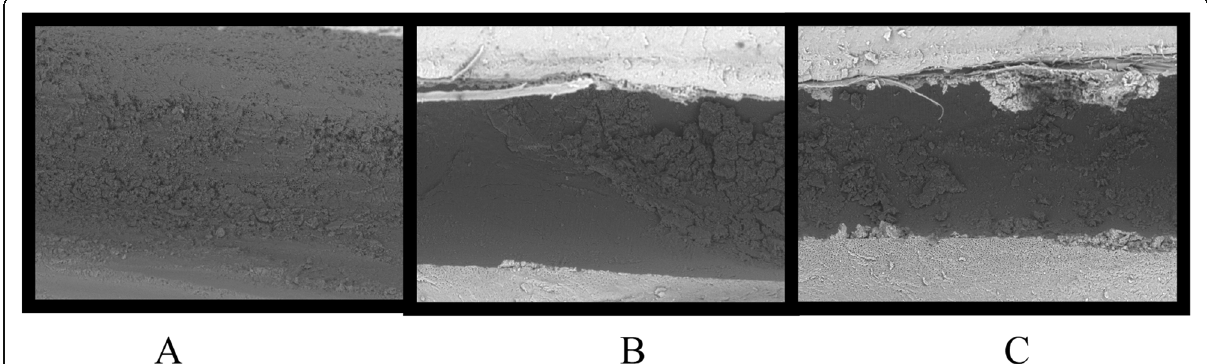
Fig. 9 SEM images of group 4. a Coronal. b Middle. c